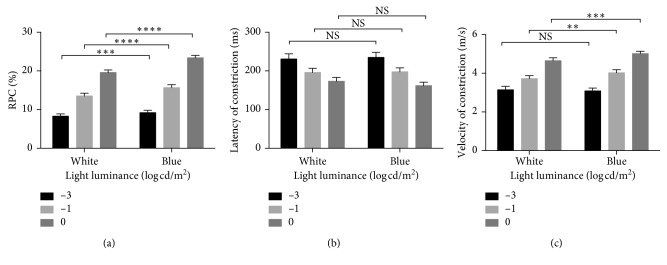
PLR-associated parameters under blue- or white-light stimuli of multiple luminance. Three levels of luminance were analyzed (−3, −1, and 0 log cd/m2). Tetrad asterisk (∗∗∗∗) indicated P value <0.0001; triple asterisk (∗∗∗) indicated P value <0.001; double asterisk (∗∗) indicated P value <0.01; NS indicated P value >0.05. PLR, pupil light reflex; RPC, relative pupillary constriction.